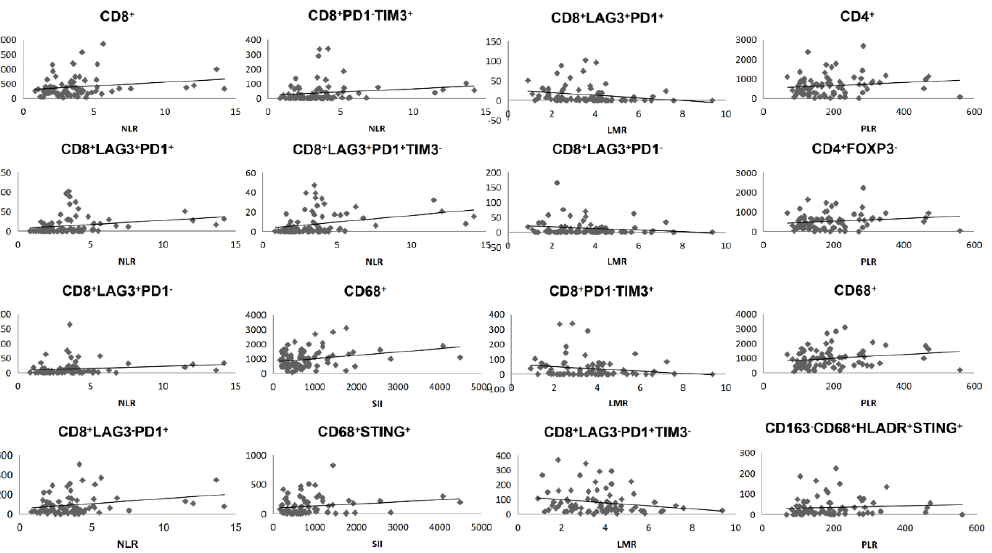
Figure 2. The relationship of NLR, LMR, PLR, and SII with the density of tumor infiltrating immune cells in tumor core.